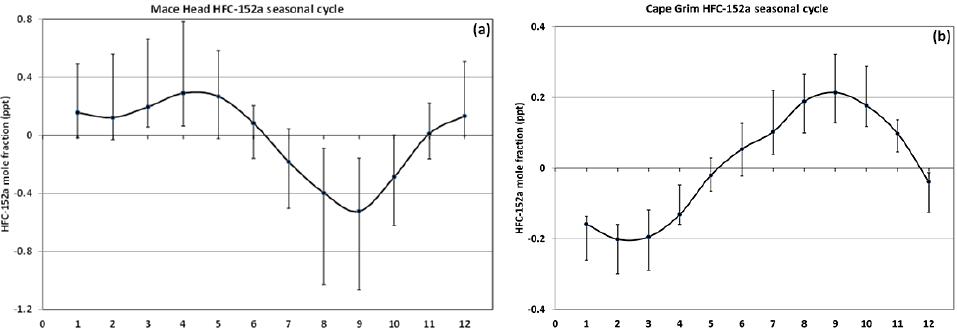
Figure 5. (a) Average seasonal cycle at Mace Head, Ireland (2004–2014). Black line represents the average for each month of these individual years and the error bars represent the min to max range. (b) Average seasonal cycle at Cape Grim, Tasmania (2004–2014). Black line represents the average for each month of these individual years and the error bars represent the min to max